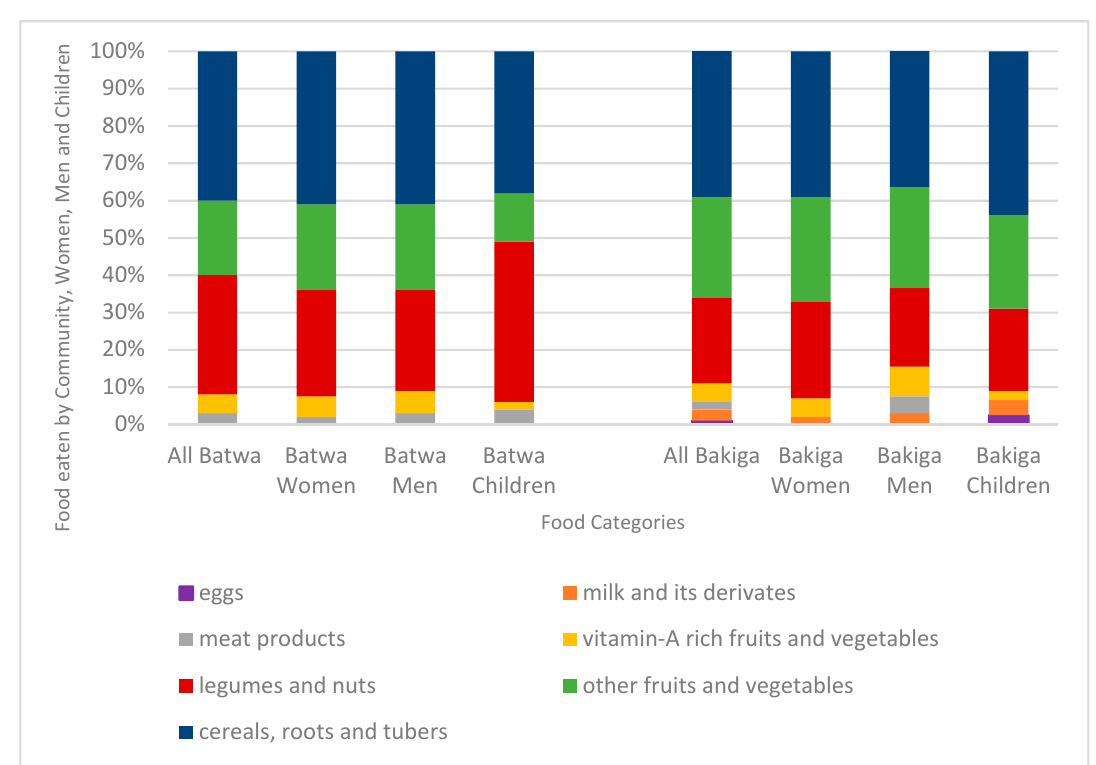
Figure 1. Percentages of frequency of different food groups eaten by the Batwa and Bakiga participants (women, men and children) in the previous 24 hours (data collected through the individual dietary survey).